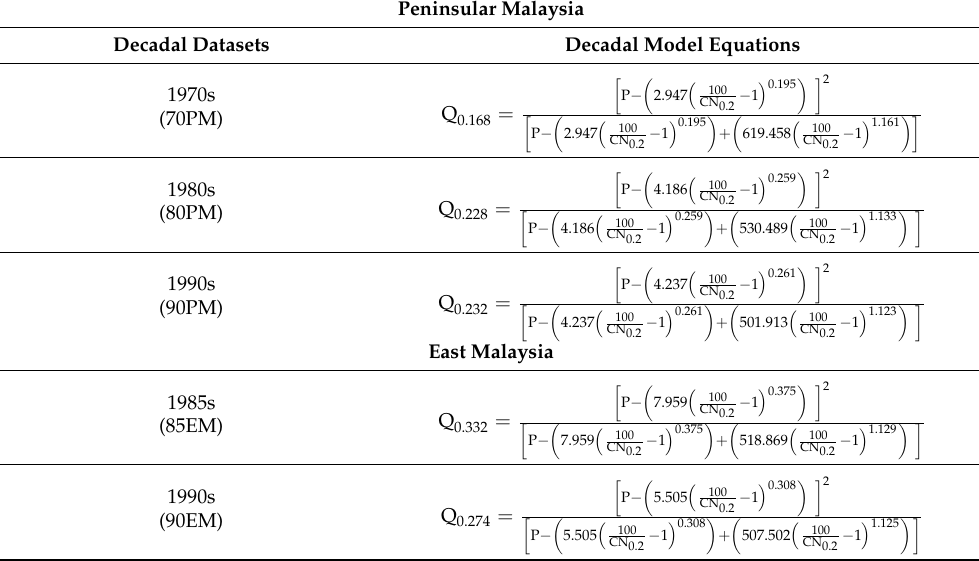
Table A3. Equations for each decadal model in Peninsular Malaysia and East